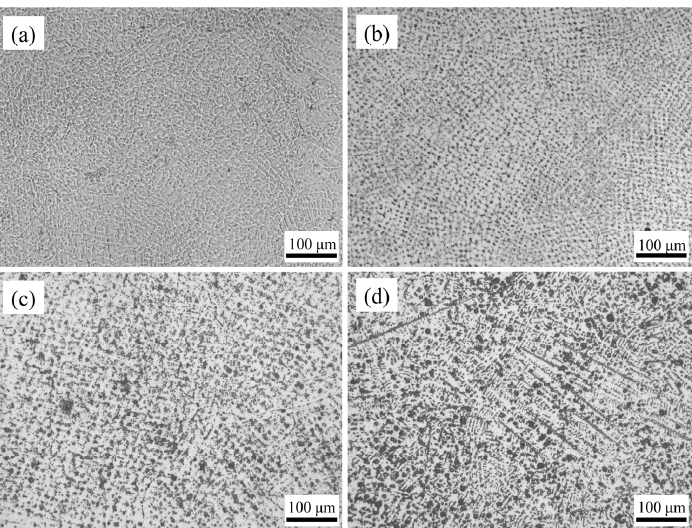
Figure 6. The surface morphologies of CoCr x FeMnNi HEA coatings: ( a ) Cr20, ( b ) Cr25, ( c ) Cr30, and ( d ) Cr35.